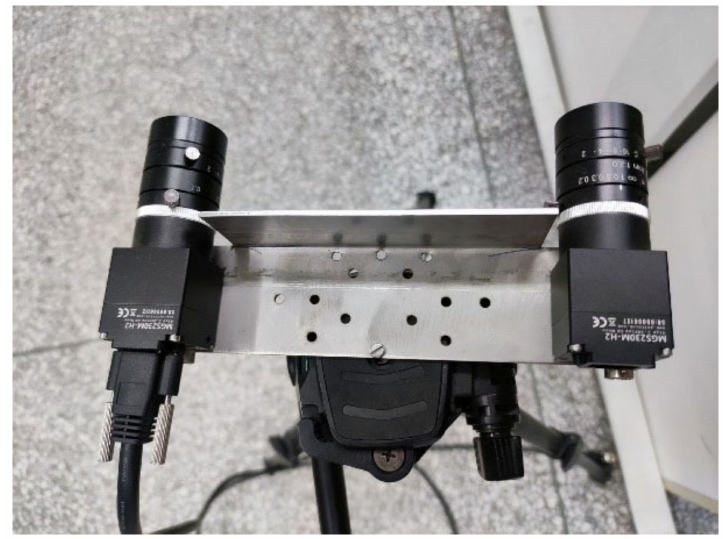
Figure 10. Binocular camera